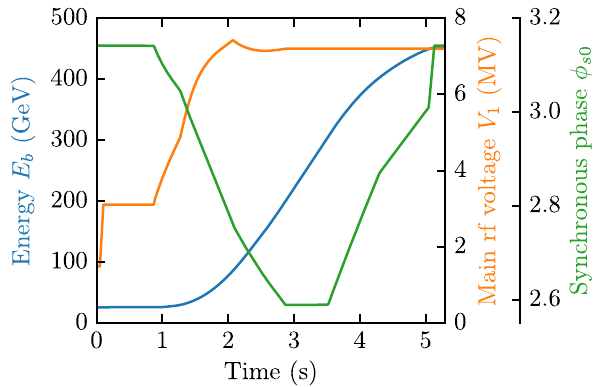
FIG. 15. The SPS acceleration cycle used during beam mea- surements [18]: beam energy (blue), main rf voltage (orange), and synchronous phase (green).